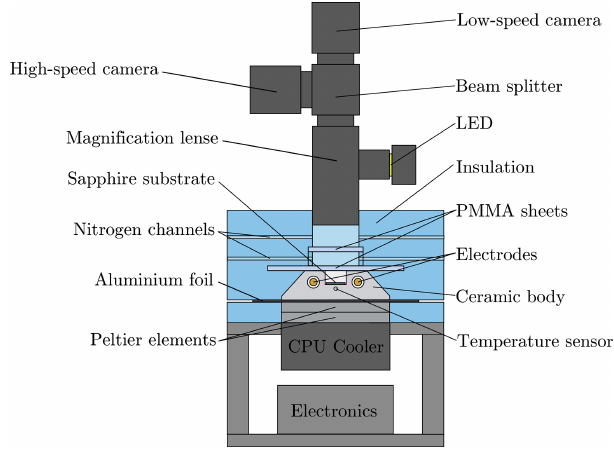
Figure 2. Schematic of the experimental setup used for the exami- nation of ice nucleation in a droplet ensemble exposed to an electric field, further extended and republished with permission of SAE In- ternational, from Löwe et al. (2019); permission conveyed through Copyright Clearance Center,